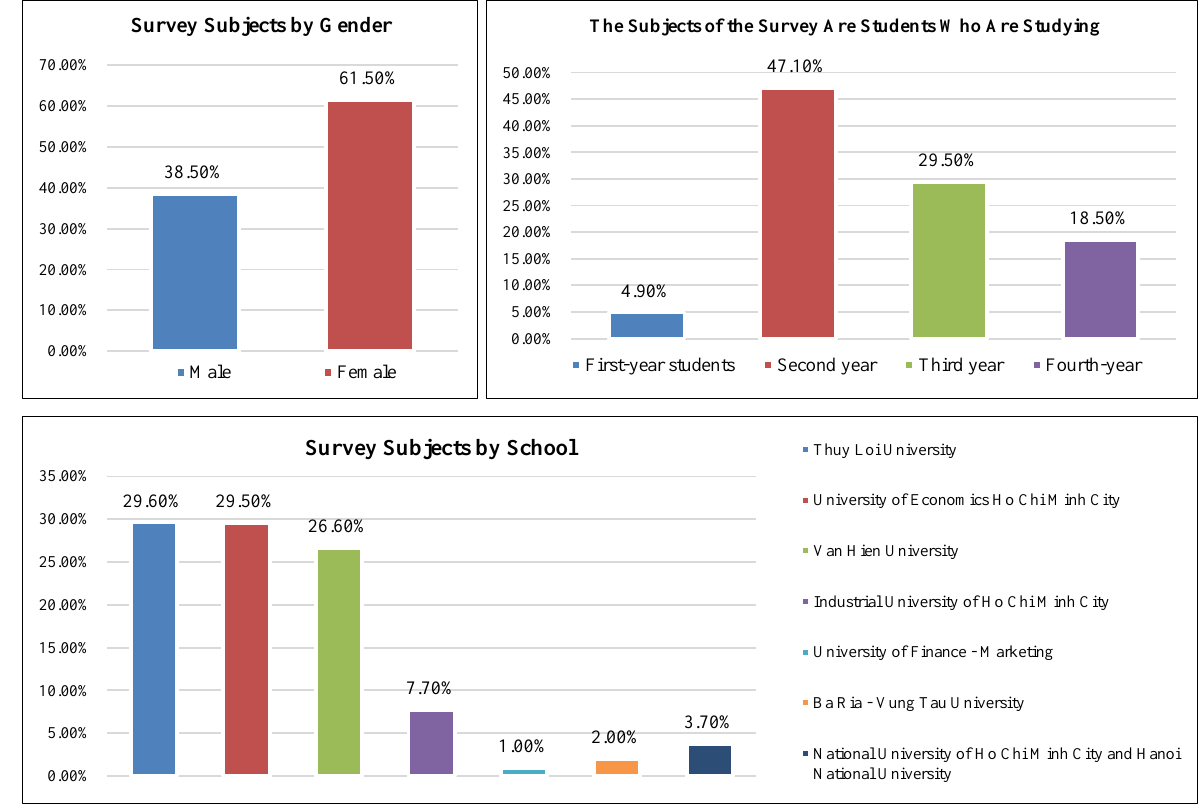
Figure 2. Characteristics of the survey